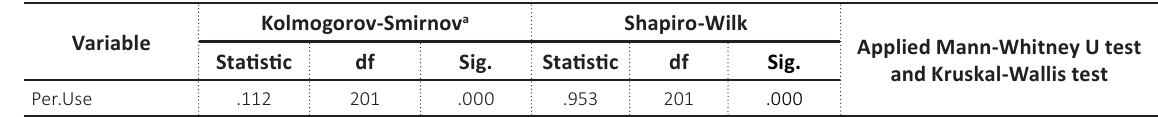
Table 1. Tests of normality